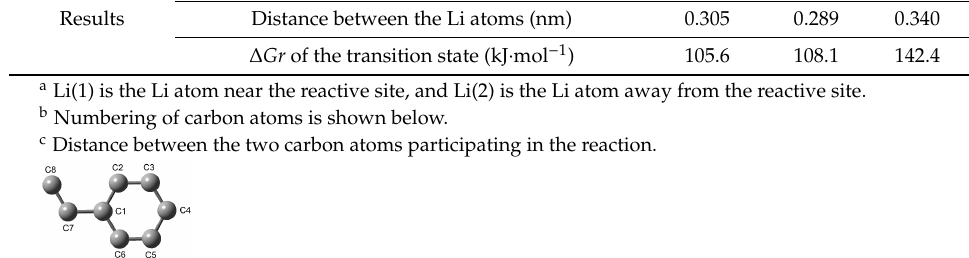
Table 1. Arrangement of the transition states shown in Figure 2 for the addition of styrene to (HStLi) 2 ( 1 − a ). Item Detail 2-a 2-b 2-c 2-d Coordination of styrene with one Two Li Two Li Two Li One Li Table 2. Arrangement of the transition states shown in Figure 3 for the addition of styrene to each Li (Li(1) a ) or two Li atoms (HStLi) 2 in Figure 1. Direction in which the side chain of Arrangement Opposite Opposite Same Same styrene approaches the reacting HSt- group Portion of the styrene phenyl group b C2 − C3 C5 − C6 C2 − C3 coordinating with Li(2) a Distance between the reacting C atoms c (nm) 0.252 0.238 0.240 Results Distance between the Li atoms (nm) 0.305 0.289